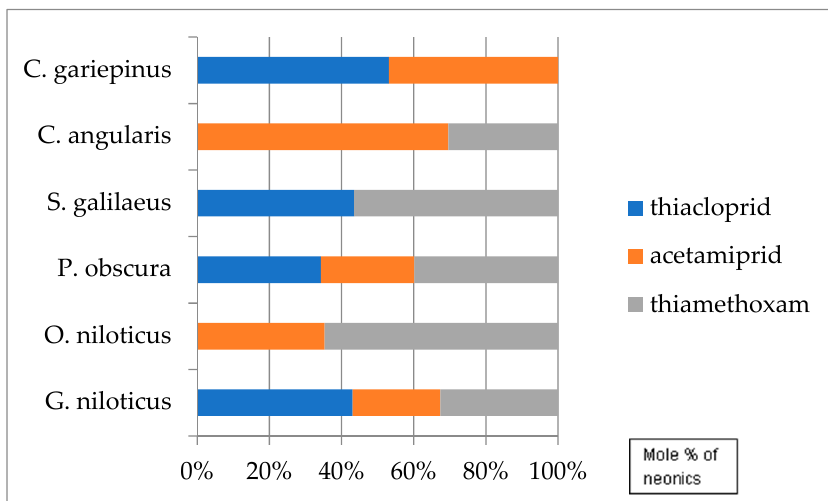
Figure 5. Relative abundances of neonics in each of the six Owena River fish species.